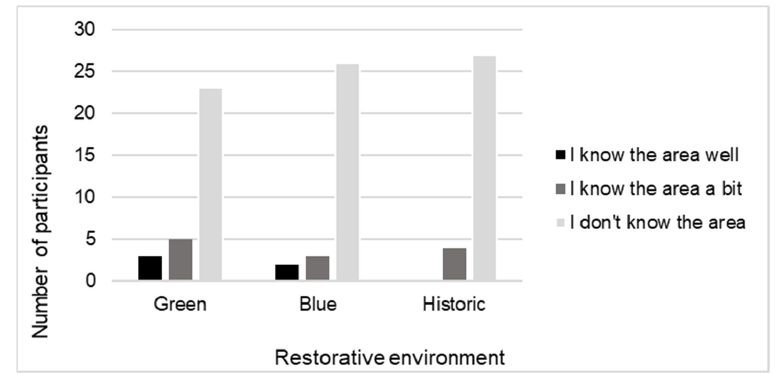
Figure 3. Familiarity with green, blue, and historic environment videos.